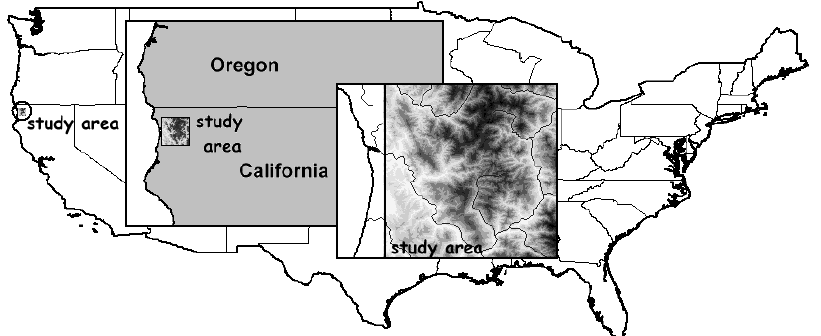
Figure 2. (a) NED DTM image. Elevation (geodetic height) values ( -24.5 to 1829 m) were rescaled in the range 255 to 0. The lighter a pixel, the lower its elevation. (b) Slope